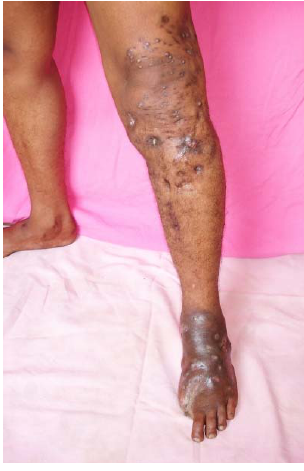
Figure 11. Massive foot actinomycetoma with leg and knee inguinal satellite lesions.